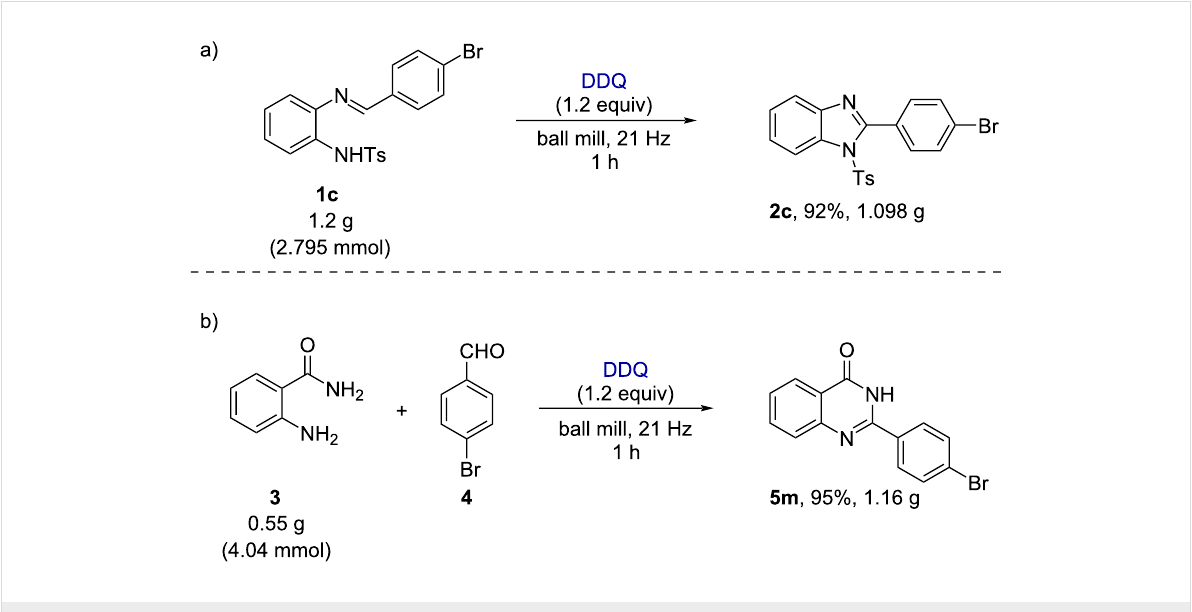
Figure 6: Large-scale synthesis. a) 1,2-Disubstituted benzimidazoles. b) Substituted quinazolin-4(3 H )-ones. Reaction conditions: reactants were milled at 21 Hz in a 25 mL milling jar containing one stainless-steel grinding ball (15 mm in diameter).